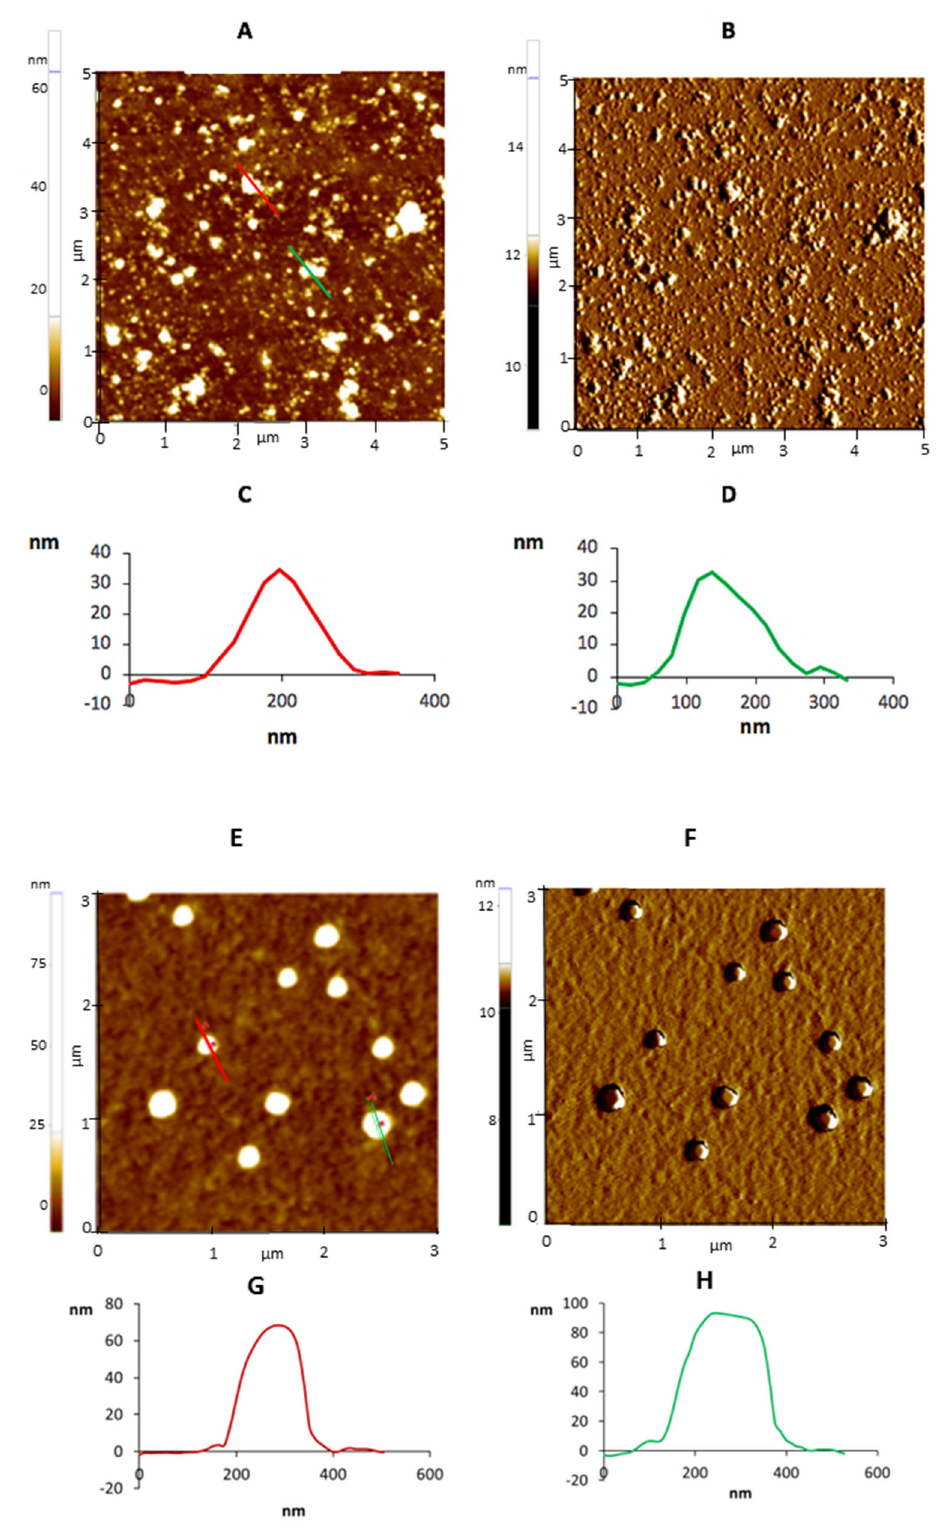
Figure 5. AFM images (5 × 5 μ m) of Ex ‐ TcT ( A – D ) Ex ‐ TcT ≈ mAb 39 immune complexes ( E – H ) on mica: ( A ) Z ‐ height; ( B ) amplitude signal; ( C ) line profile: 35 nm for height; ( D ) line profile: 32 nm for height; ( E ) Z ‐ height; ( F ) amplitude signal; ( G ) line profile: 65 nm for height; ( H ) line profile: 87 nm for height.